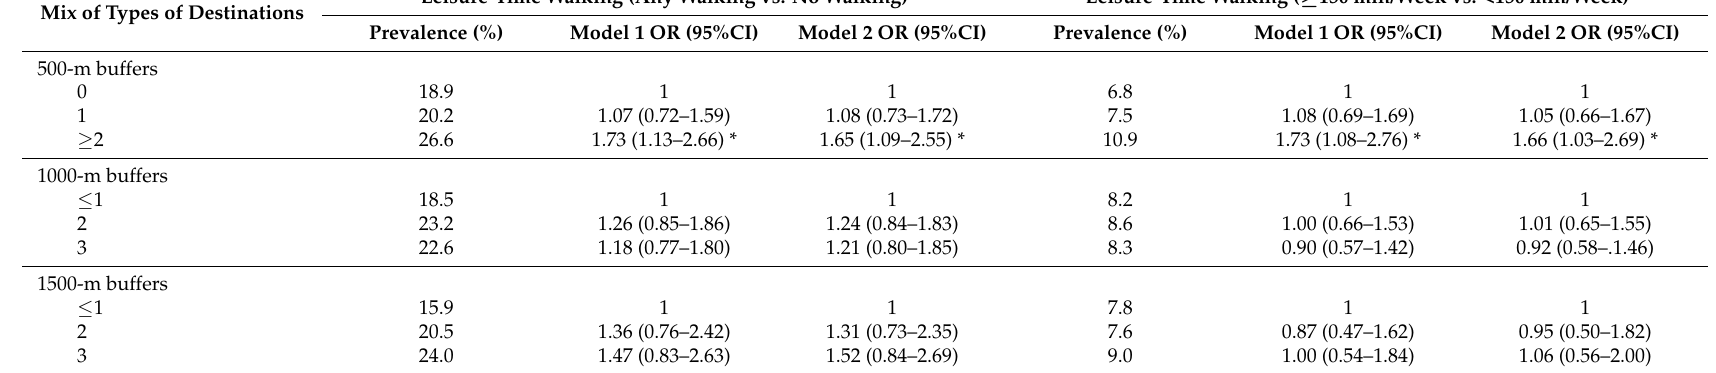
Table 4. Odds ratios (OR) for the association between participating in leisure-time walking and the mix of the types of destinations within buffers of 500 m, 1000 m, and 1500